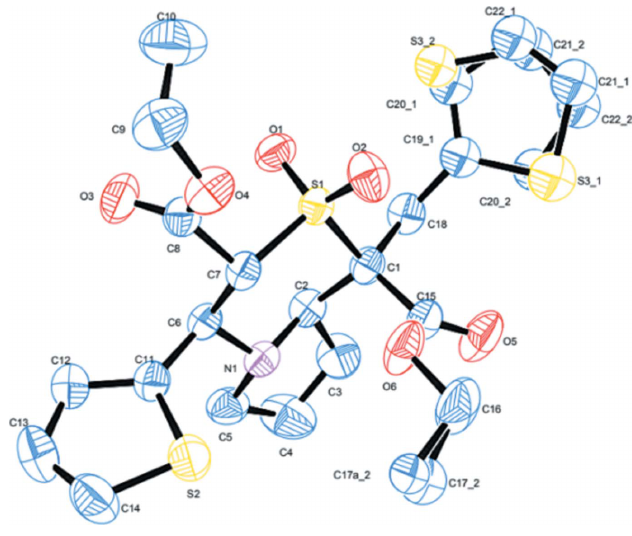
Figure 1 The molecular structure of the title compound, with atom labels and 50% probability displacement ellipsoids for non-H atoms. H atoms have been omitted for clarity.